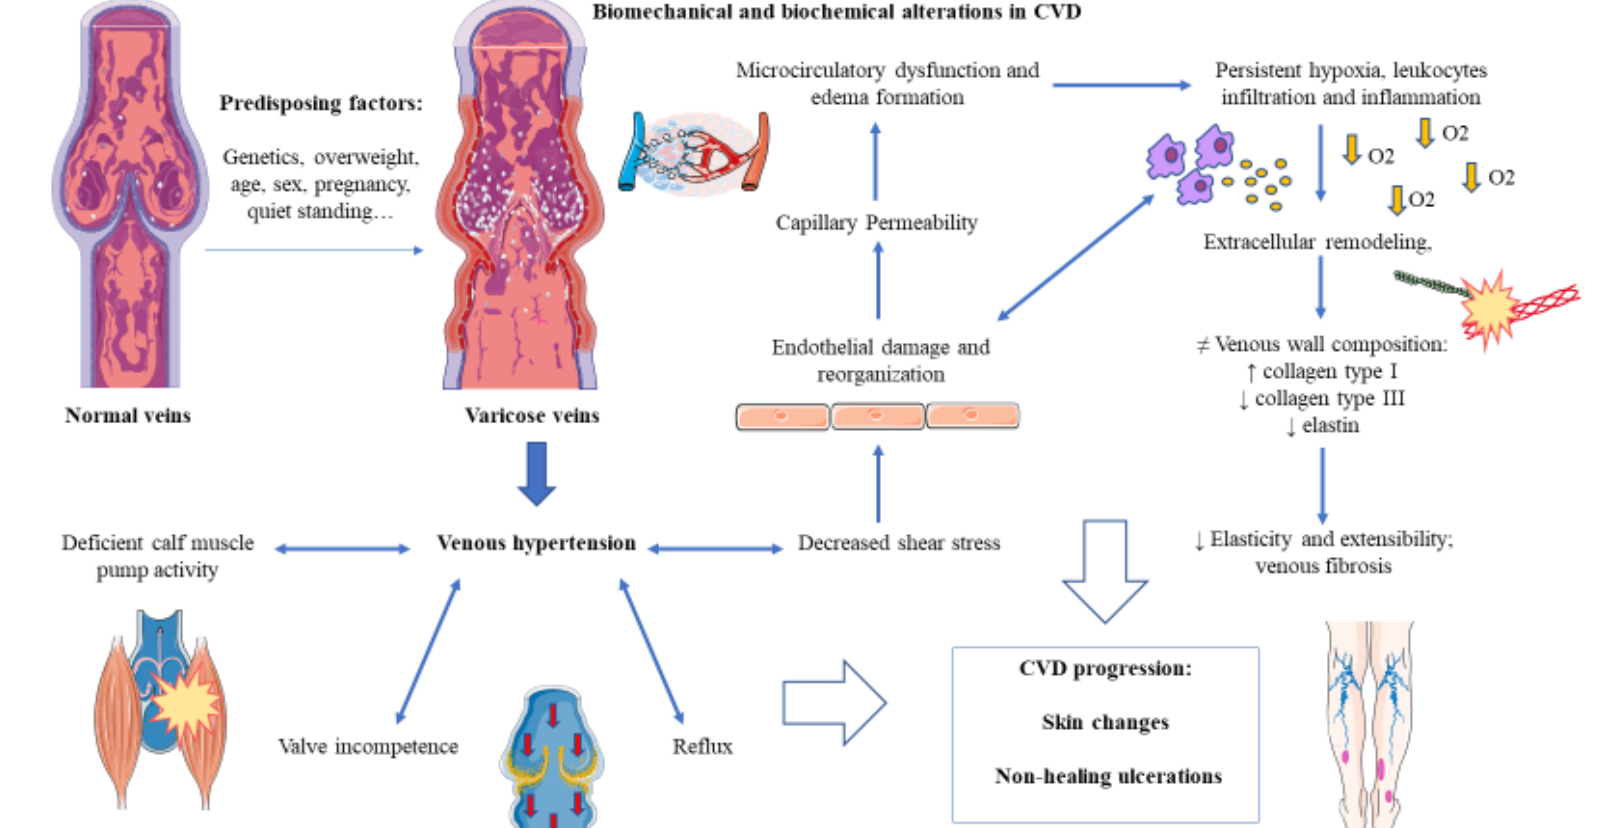
Figure 3. Biomechanical and biochemical alterations in CVD. As showed, ambulatory venous hypertension promotes a set of changes in the vascular wall, leading to a < n altered shear stress. The altered hemodynamic damage the endothelium, enhancing capillary permeability, leukocytes recruitment, lymphatic impairment, and edema formation. The microcirculatory dysfunction associated with these changes creates a hypoxic environment, and together with the inflammatory environment provide a extracellular matrix remodeling, eventually resulting in different venous wall compositions, reduced elasticity and extensibility, and venous fibrosis. This cycle is responsible for maintain and aggravate venous hypertension, getting worse with valve incompetence, reflux, and abnormal functioning of the calf muscle pump. Overall, these mechanisms are responsible for the progression of VVs to the most serious manifestations, such as skin changes and ulcerations.